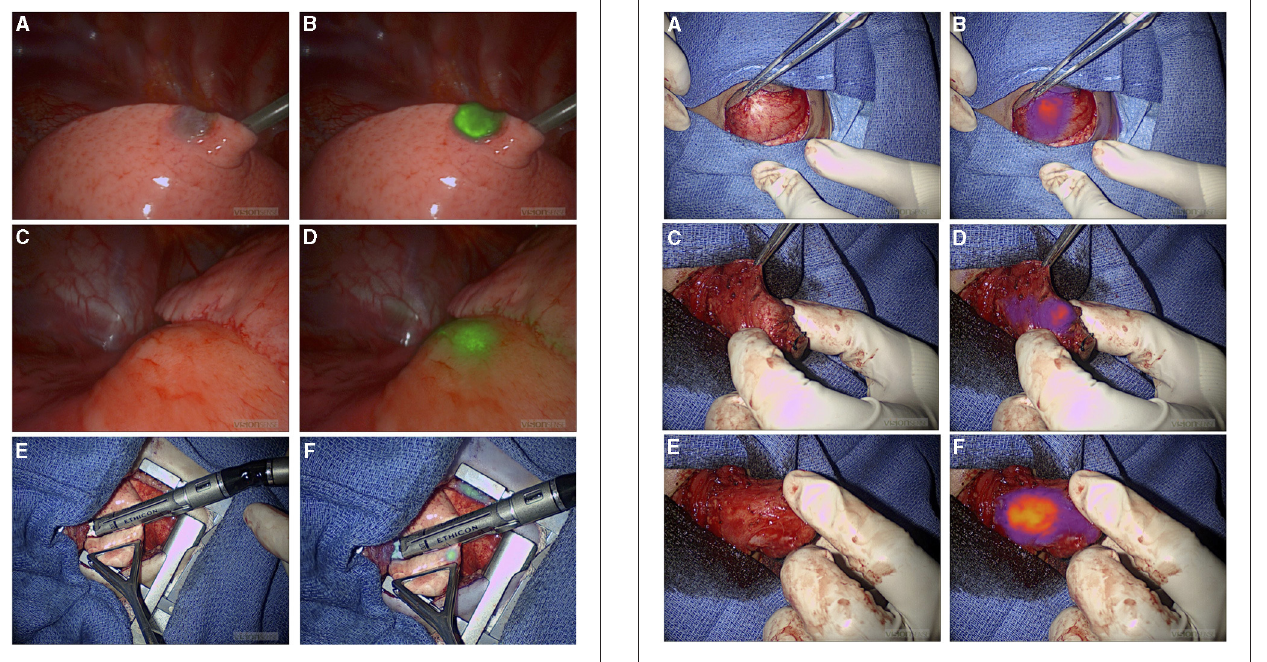
FIGURE 2 | NIR guide localization of margin extension. (A,B) Initial view of a chest wall myoepithelial carcinoma with white light (A) and NIR (B) . NIR, near infrared. (C–F) Medial extension of the myoepithelial carcinoma was not appreciated with standard of care white light and tactile feedback (C) , but it was recognized by NIR (D) . Medial extension of the tumor was further localized with NIR after medial dissection proceeded (E) and (F) . NIR, near infrared.